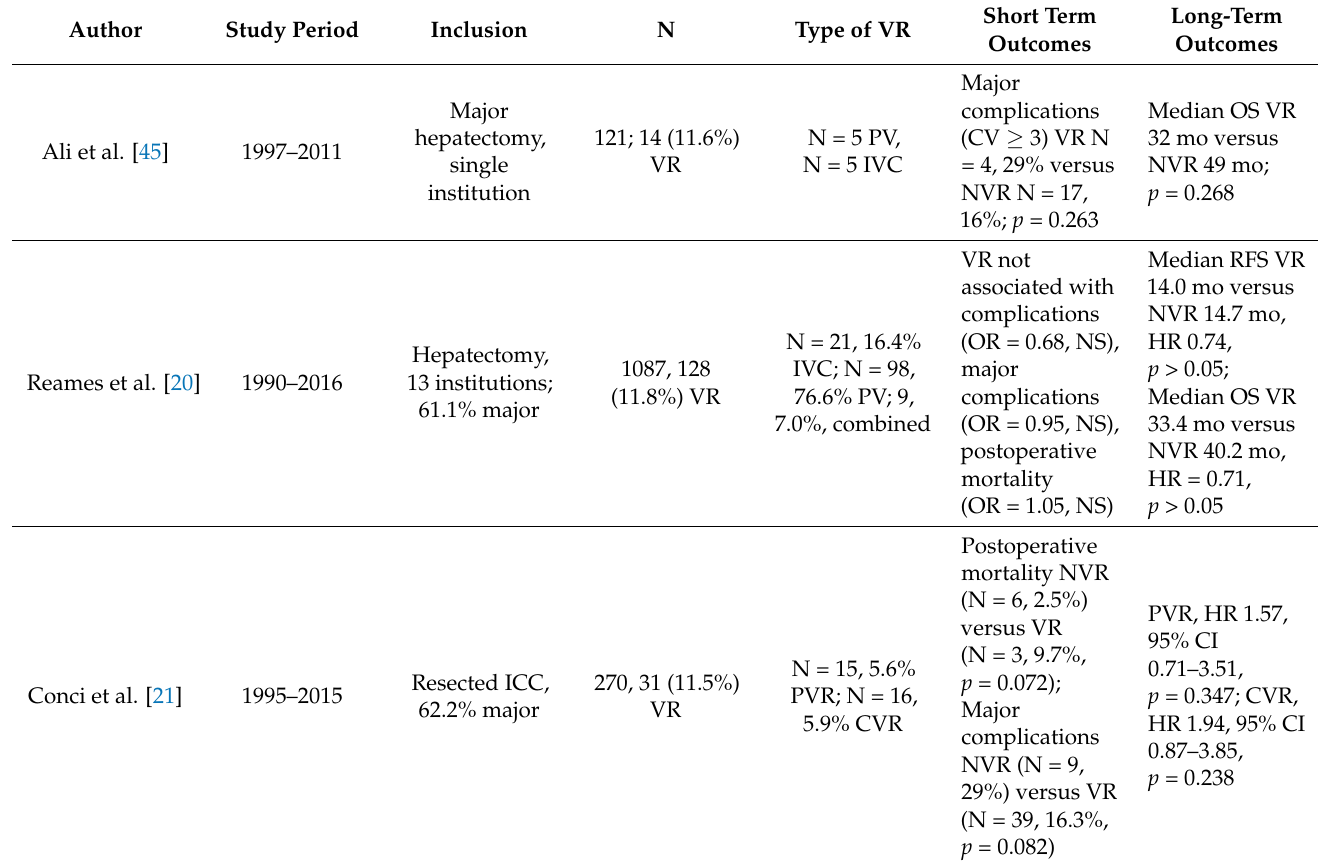
Figure 1. Infiltrative intrahepatic cholangiocarcinoma (ICC) (short, white arrow) with involvement of the right portal vein on magnetic resonance imaging (MRI; ( A ), coronal and ( B ), axial) and computed tomography (CT; ( C ), coronal and ( D ), axial). ICC, intrahepatic cholangiocarcinoma; MRI, magnetic resonance imaging; CT, computed tomography. Table 1. Selected references: vascular resection for intrahepatic